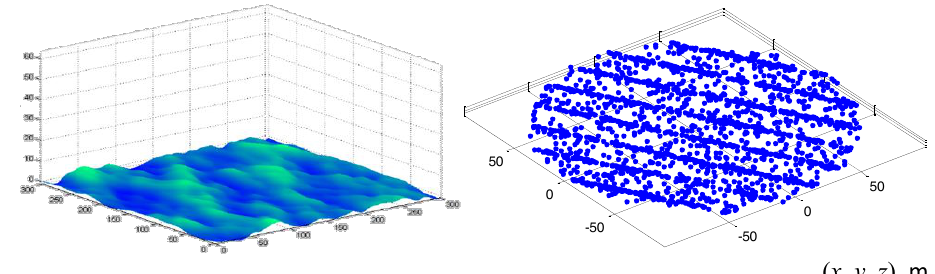
Fig. 5. Complex model and simplified facet field for modeling sea surface reflectors.